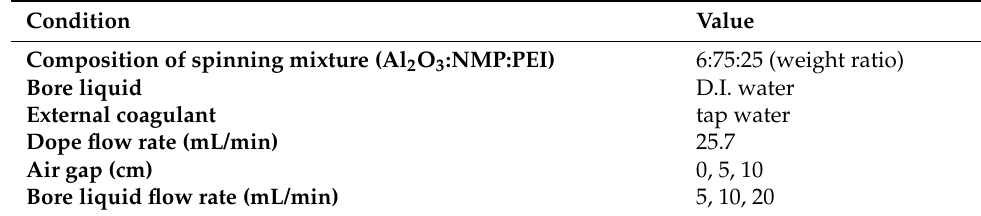
Table 1. Summarized spinning